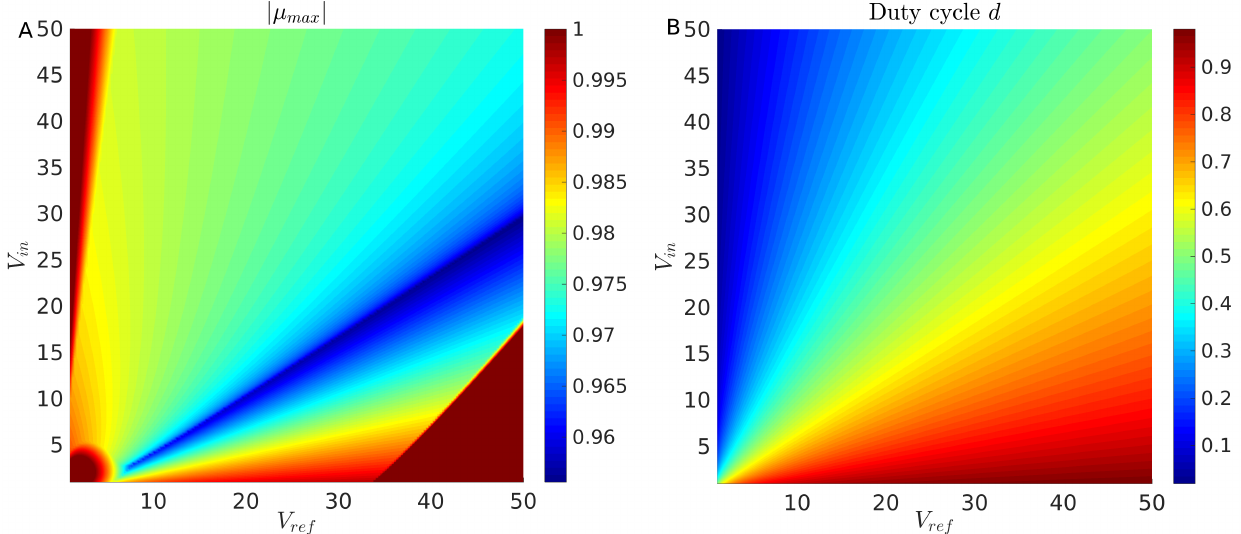
Figure 5. ( A ) Heat map of the maximal Floquet multiplier in the parameter space ( V ref , V in ) ; ( B ) Heat map of the duty cycle solution (18) as in ( A